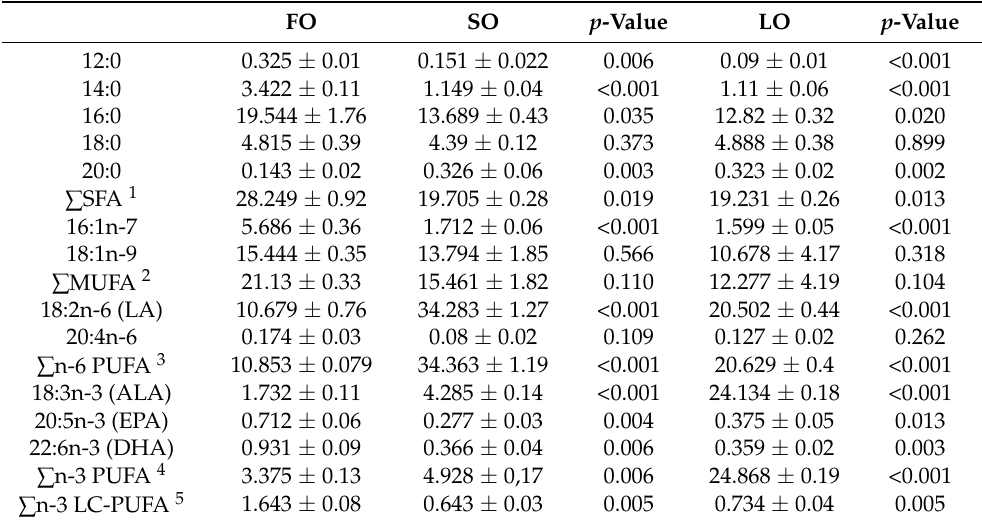
Table 4. Fatty acid profiles (% total fatty acids) in adipose tissue of large yellow croaker ( Larmichthys crocea ) fed diets with FO replaced by SO and LO. FO SO p -Value LO p -Value